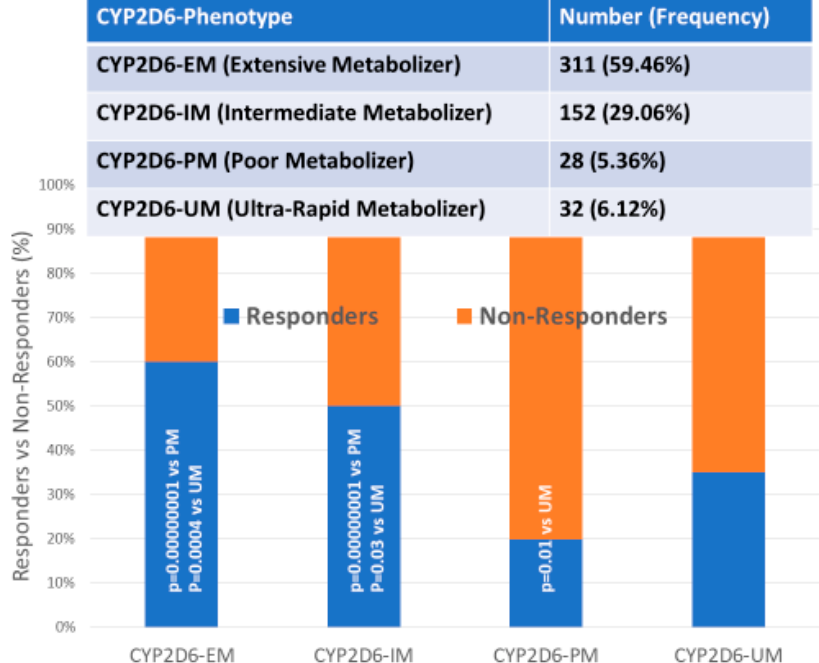
Figure 5. TOMM40-related responder / nonresponder rate in patients with Alzhimer’s disease treated with a multifactorial / combination treatment for one year. Responders: Final MMSE score > basal MMSE score. Nonresponders: Final MMSE score < basal MMSE score. Data Source: Cacabelos et al., 2014.